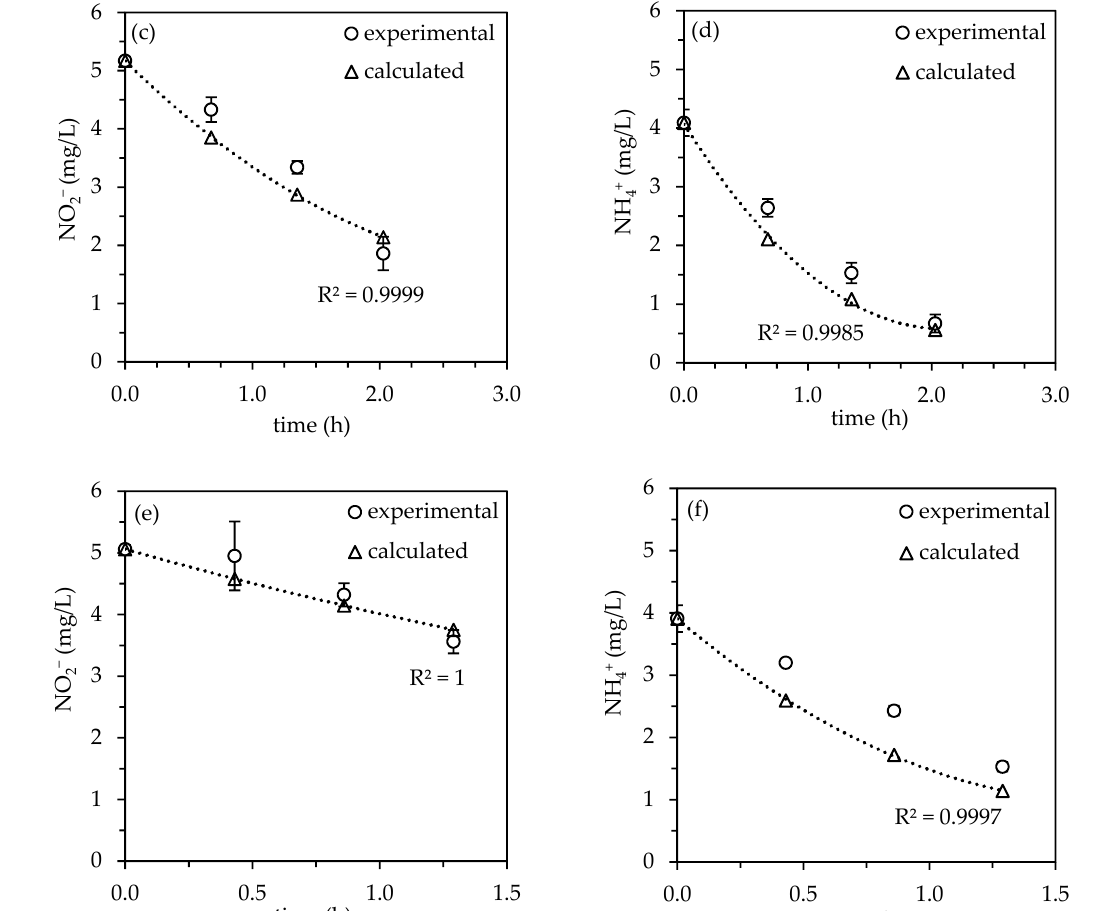
Figure 3. Calculated filter velocity-dependent reaction pseudo first-order for NH 4+ and NO 2 − removal compared to experimental data: ( a , b ) for 0.043 m/h; ( c , d ) for 0.043 m/h; and ( e , f ) for 0.068 m/h (matrix: Elbe-/tap water (1:10); v F = 0.032, 0.043, 0.068 m/h; c 0 (NH 4+ ) = 4.3 mg/L; c 0 (NO 2 − ) = 5.7 mg/L; c 0 (DOC) = 2.5 mg/L; pH: 7.8; T = 22 ◦ C; n = 3). NH 4+ and NO 2 − removal decreased with effective hydraulic retention times for all filter velocities investigated. The main difference between NH 4+ and NO 2 − removal is represented by the degree of comparability (discrepancy between the experimental and calculated) data. Calculated NO 2 − removal for all filter velocities fits better with experimental data than does NH 4+ removal. The best degree of comparability is achieved for NO 2 − removal at 0.032 m/h ( k = 0.4928 1/h)—Figure 3a. With increasing filter velocity, the NO 2 − removal rate declines as a result of decreasing reaction rate constants (0.043 m/h: 0.4351 1/h; 0.068 m/h: 0.2314 1/h—Figure 3c,e. While increasing the filter velocity from 0.032 m/h to 0.043 m/h had no significant effect on NH 4+ removal efficiencies and reaction rate constants (0.8275 1/h and 0.6738 1/h, Figure 3b,d), a further increase to 0.068 m/h decreased